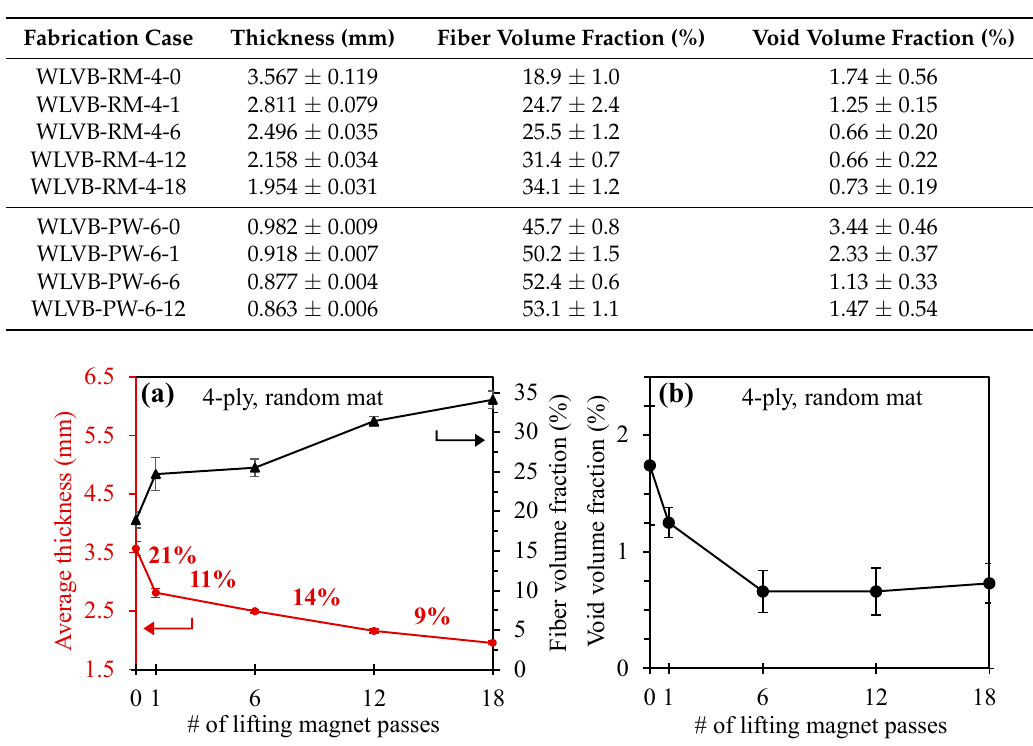
Table 3. Thickness and fiber and void volume fractions for 4-ply random mat and 6-ply plain weave laminates fabricated with an increasing number of passes (i.e., 1, 6, 12, and 18 passes for random mat and 1, 6, and 12 passes for plain weave) of a lifting magnet ( n = 6 for fiber volume fraction and void volume fraction; n = 70 for thickness of random mat laminate; and n = 126 for thickness of plain weave laminate, 95% confidence intervals for all data).